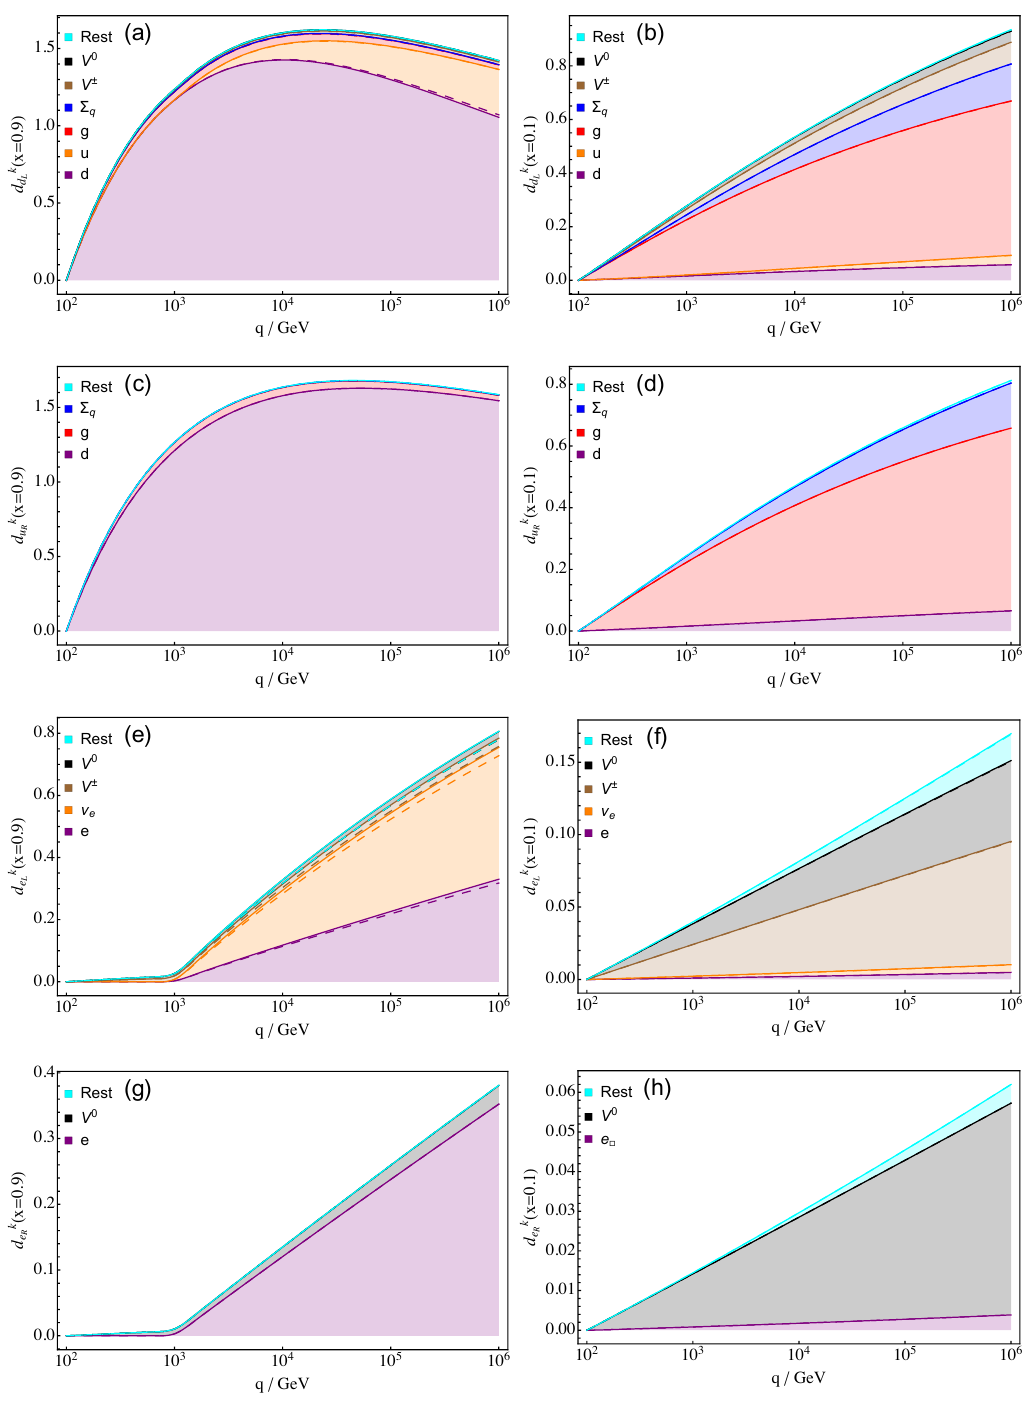
Figure 2 . The fragmentation functions at (left) x = 0 : 9 and (right) x = 0 : 1 for (a,b) i = d L , (c,d) d R , (e,f) e L , (g,h) e R . The di(cid:11)erent values of k are stacked on top of each other. Dashed/solid lines show DL/NLL resummed results.